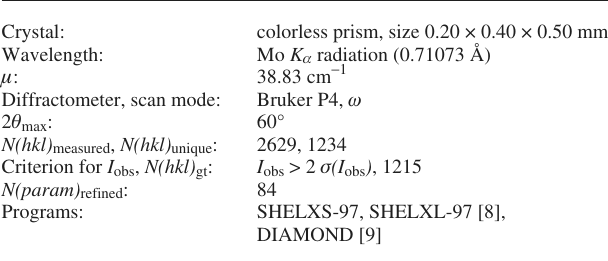
Table 1. Data collection and